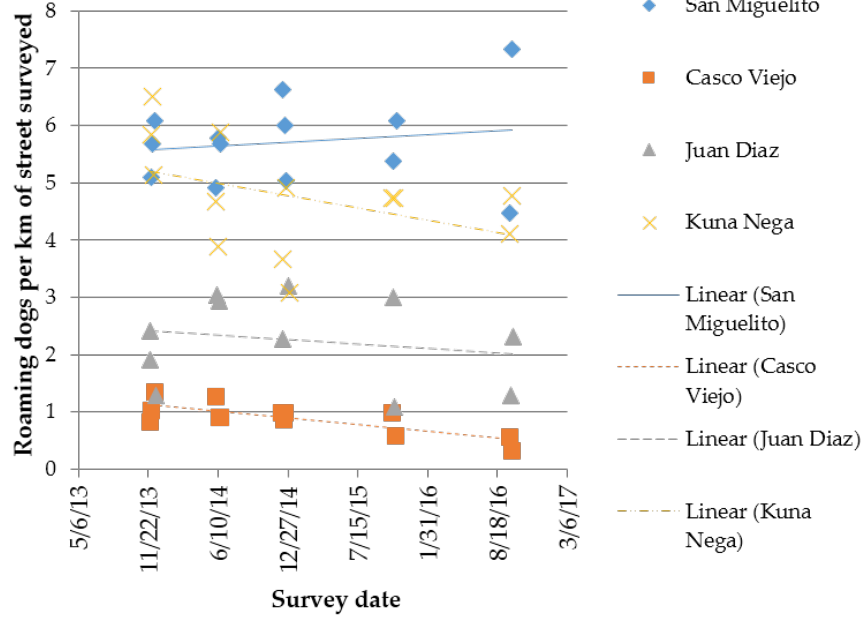
Figure 4. Roaming dogs per km of street surveyed for all four Panama City routes, showing the data for the two or three replicates at each survey event and five survey events across time.